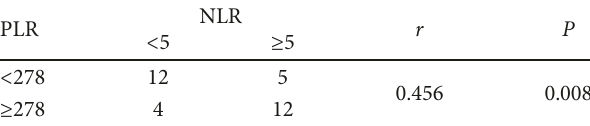
Table 3: Correlation between serum PLR and NLR